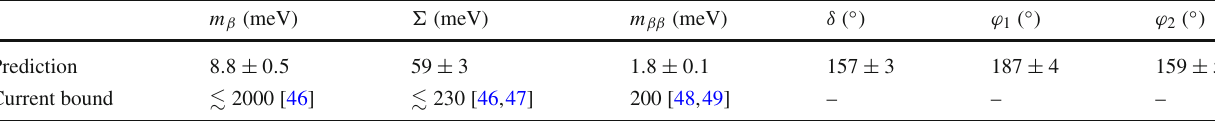
Table 3 Predicted values and current bounds for the neutrino observables. The current bounds were taken from Ref. [50]. As explained in the text, the ranges shown here correspond to perturbations of the best fit point with χ 2 / dof (cid:3)